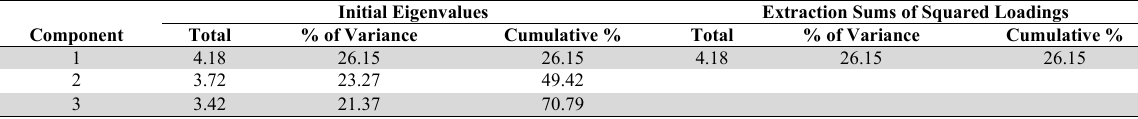
Total Variance Explained Component